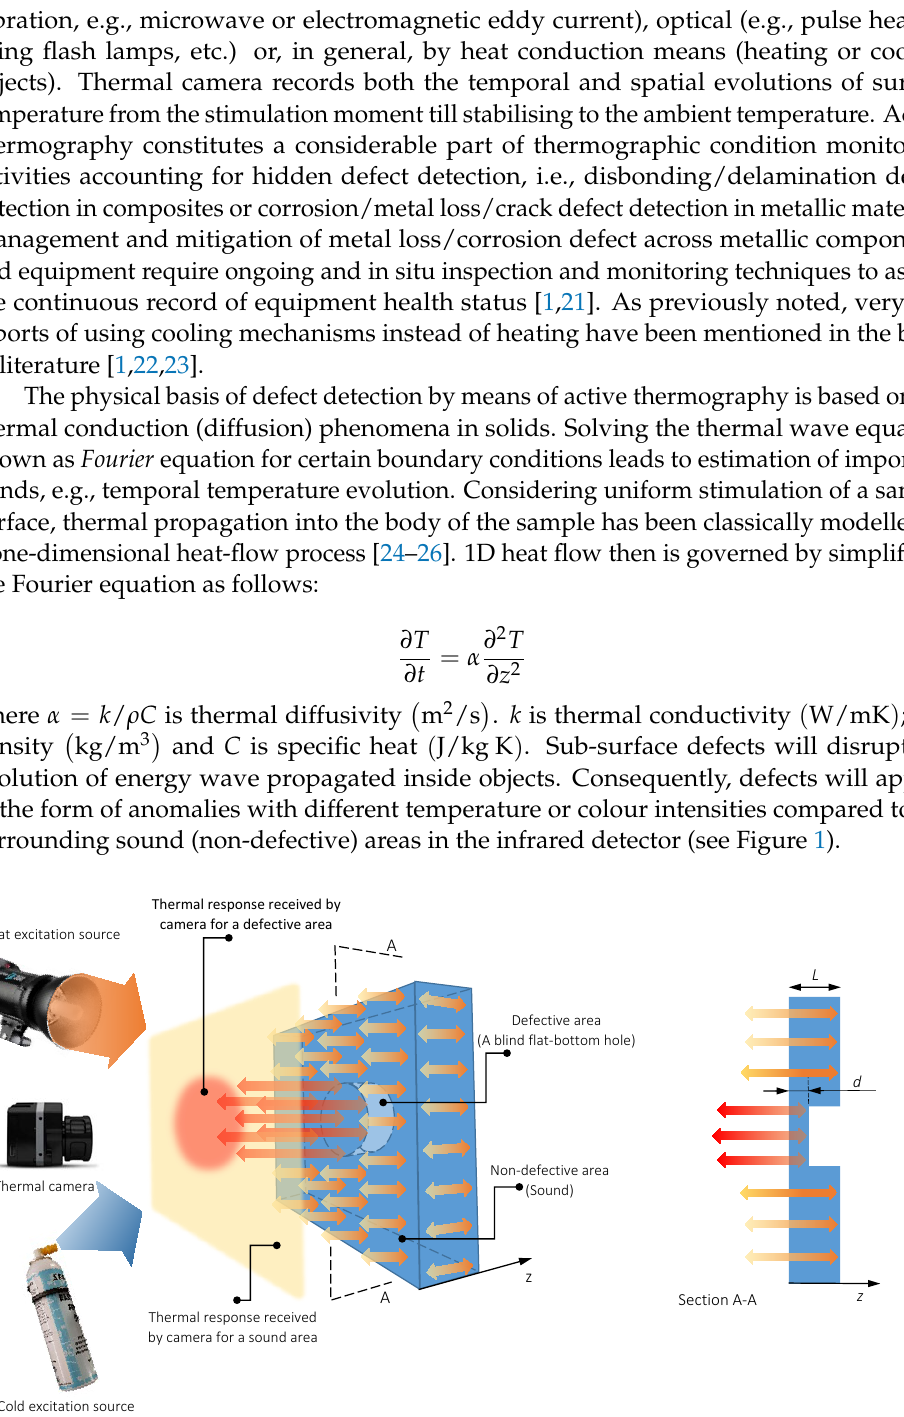
Figure 1. Schematic of thermal diffusion and response through a defective solid, retrieved from [1]. The solution of Equation (1) for a Dirac delta pulse (an intense unit-area pulse of so short a duration that no measuring equipment is capable of differentiating it from a shorter pulse [27,28]) from a plane source of strength J 0 / ρ C launched from the surface (z = 0) of a semi-infinite medium (z >> 0) was proposed as follows